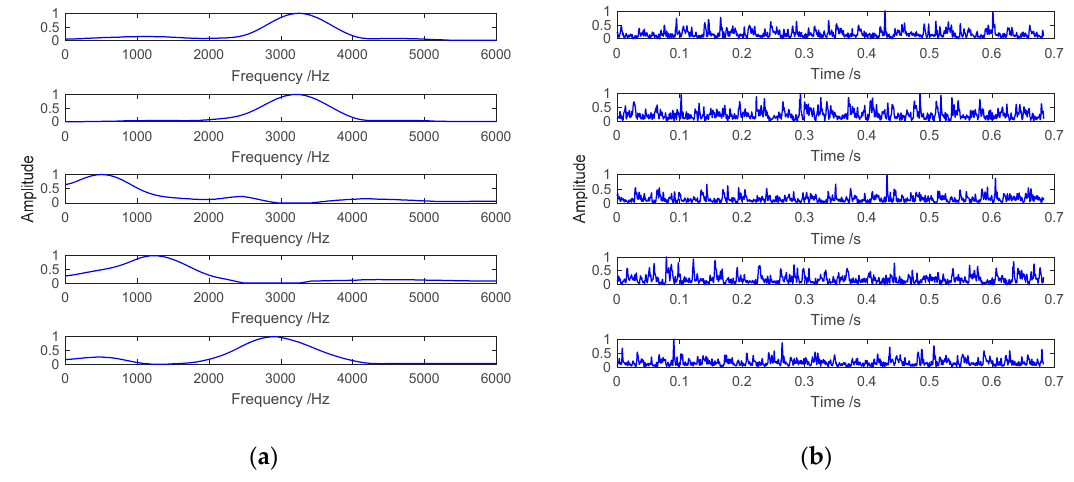
Figure 14. Decomposed factors of SNTF: ( a ) Frequency matrix A ; ( b ) time matrix B .